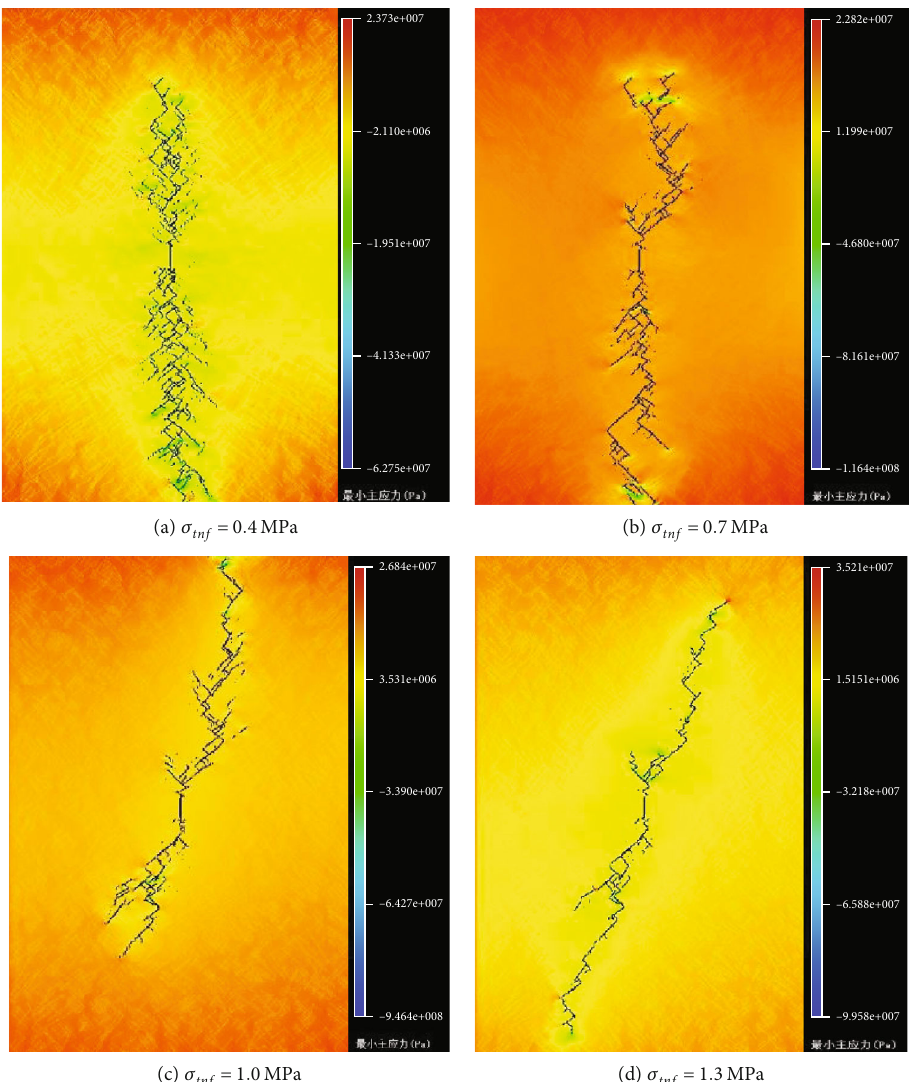
Figure 12: Hydraulic fracture propagation patterns under di ff erent tensile strength of